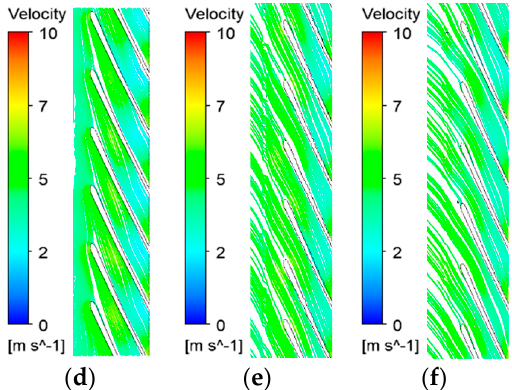
Figure 19. Comparison of streamline at different spans under 1.0 Q d : ( a ) Origin scheme 1, span = 10%; ( b ) Origin scheme 1, span = 50%; ( c ) Origin scheme 1, span = 90%; ( d ) Optimal scheme 3, span = 10%; ( e ) Optimal scheme 3, span = 50%; ( f ) Optimal scheme 3, span = 90%.